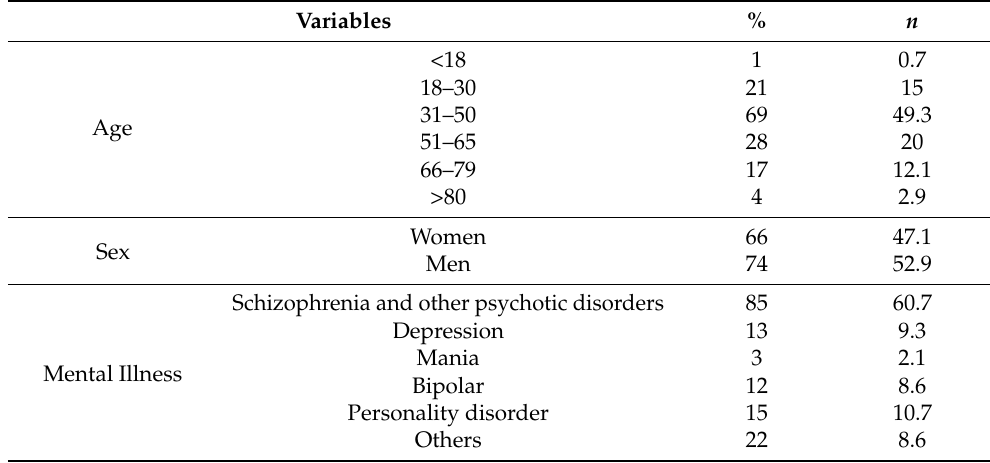
Table 1. Sociodemographic properties ( n = 140).